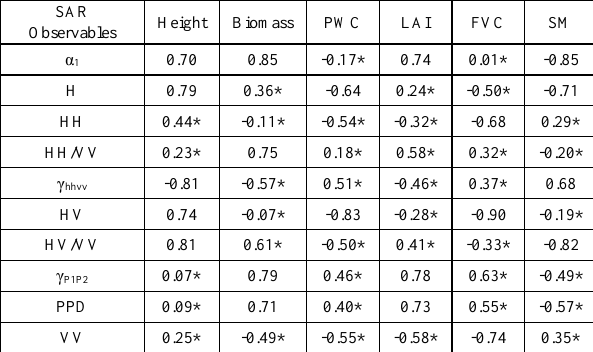
Table 7. Correlation (R Pearson) between SAR observables and field estimations for H9 (pasture). Non-significant correlations at 95% confidence level are indicated by